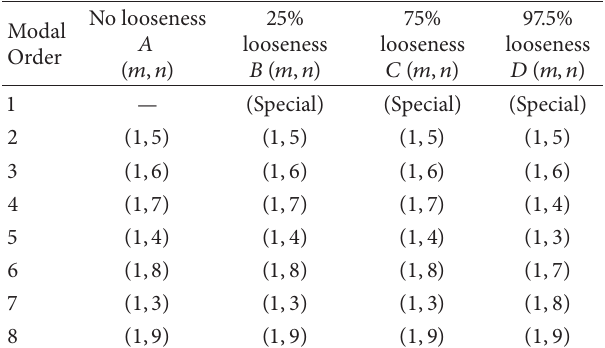
Table 5: Mode shapes of TCS under BLB with different looseness levels.